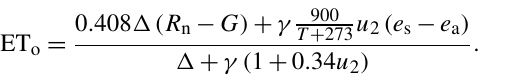
The period studied was from 2000 to 2018, although the start date may fluctuate depending on the availability of